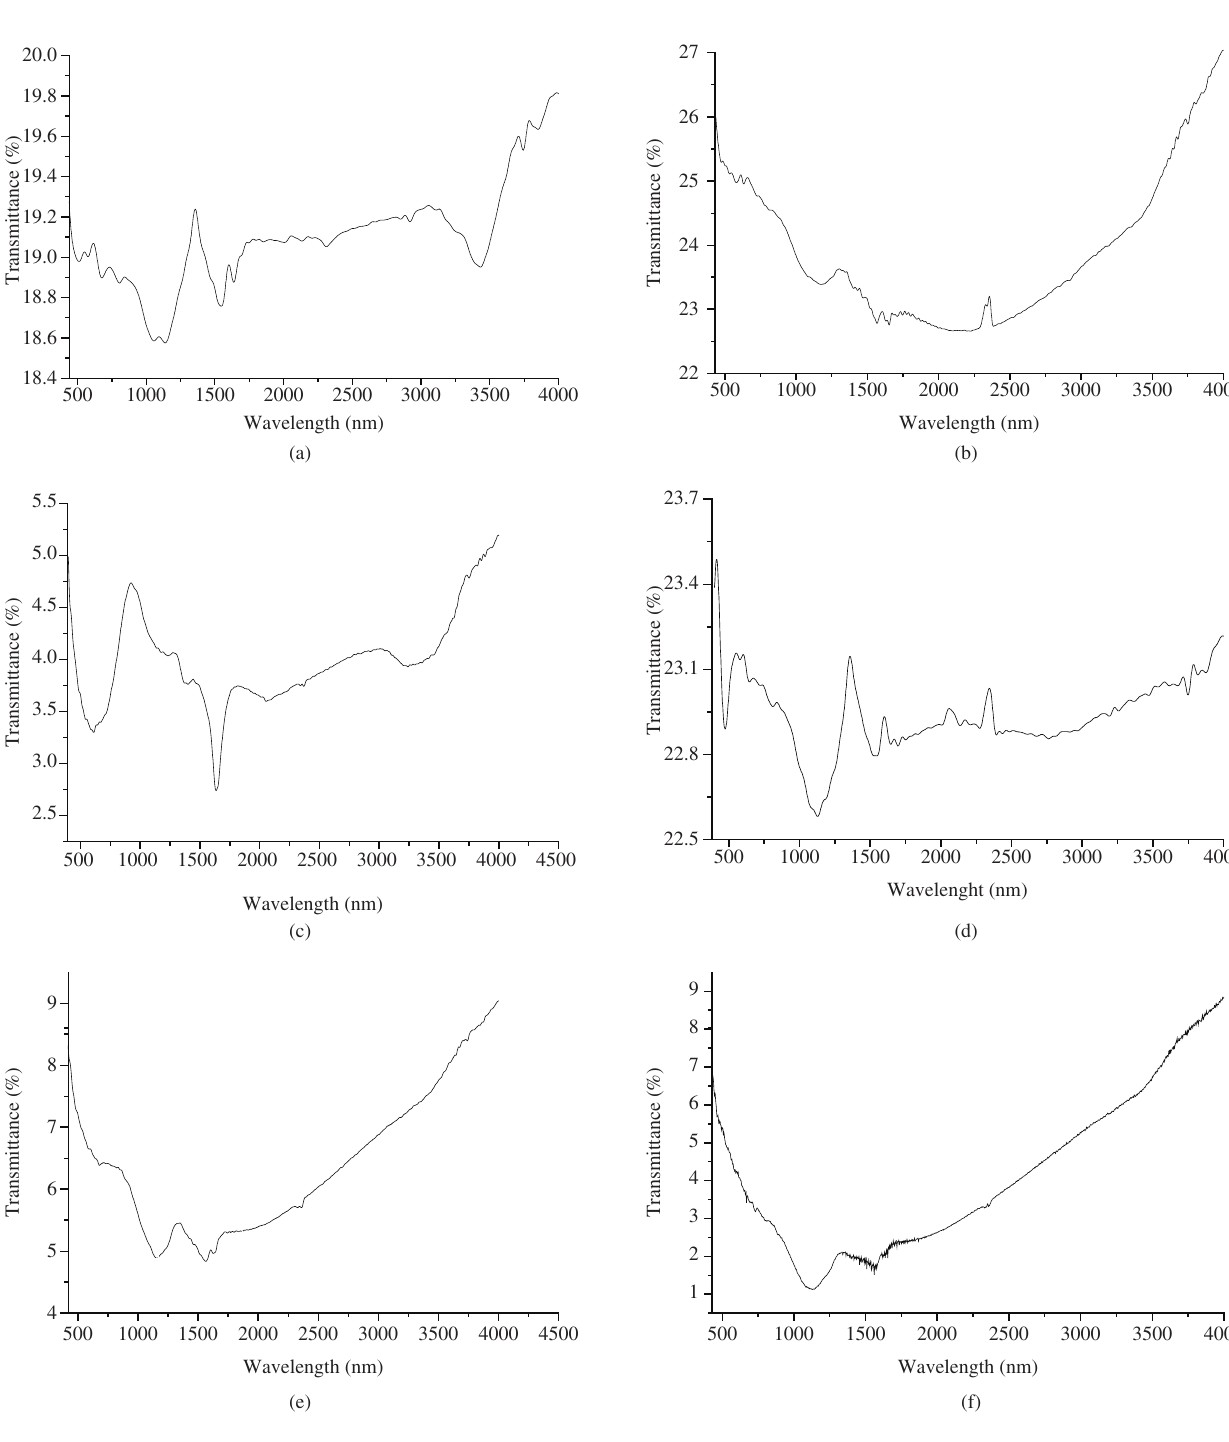
Figure 2. FTIR spectra of the a) ACF from UCM, b) CS, c) NORIT GAC, d) MNS, e) PWR and f)